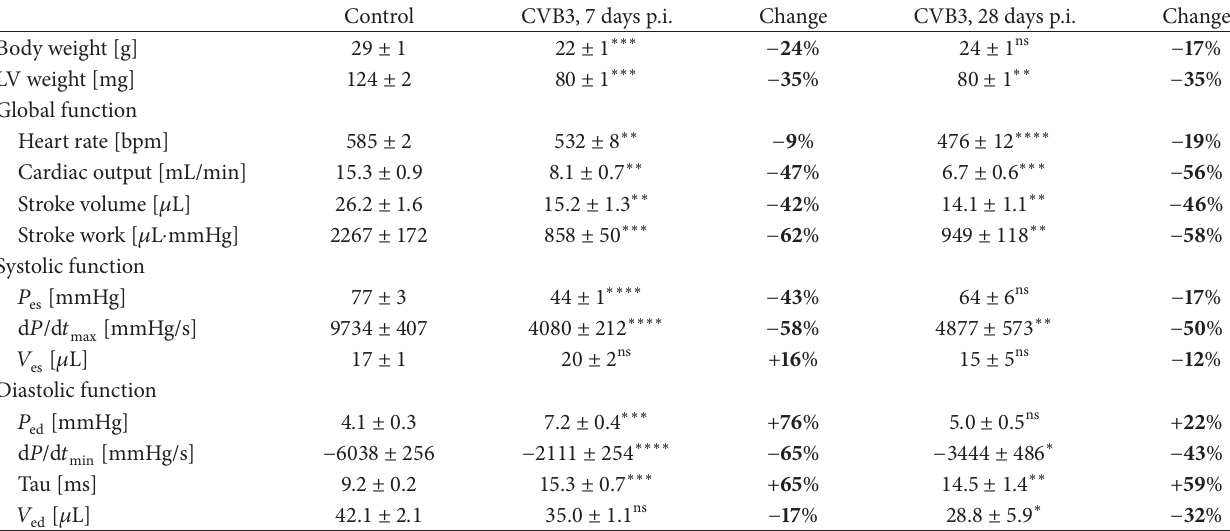
Table 1: Gravimetric characteristics and hemodynamic function of C57BL/6J mice 7 and 28 days after CVB3 infection. Control CVB3, 7 days p.i. Change CVB3, 28 days